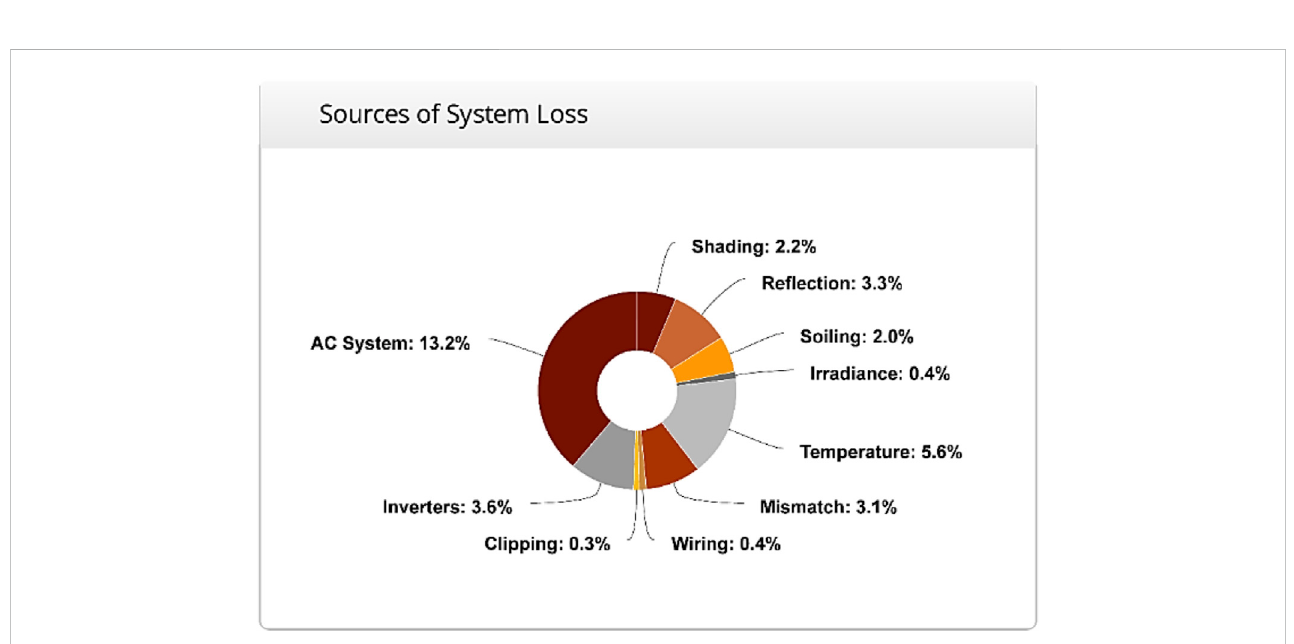
FIGURE 12 Losses in the proposed